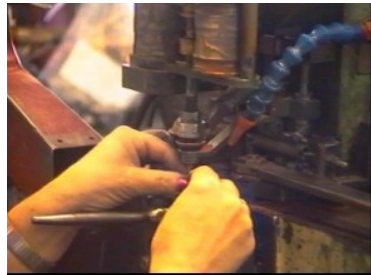
Figure 5. The inner memory María Ruido (2002). Reprinted with permission from María Ruido (2002). Copyright 2002 Copyright Owner’s María Ruido.